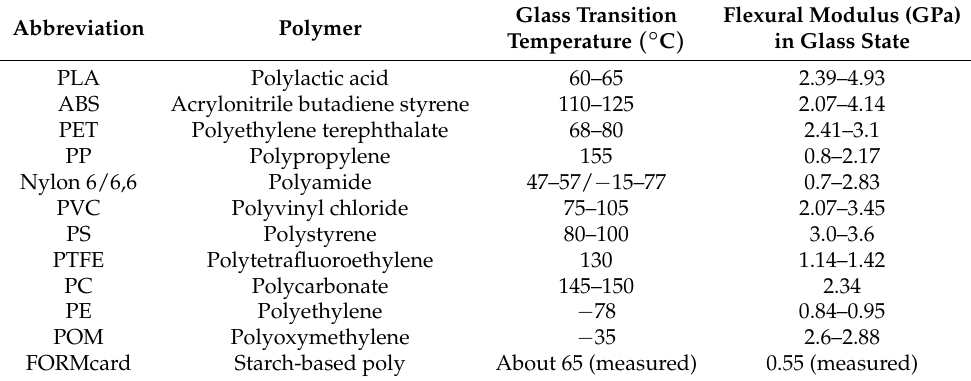
Table 1. Properties of commonly used and our applied thermoplastics